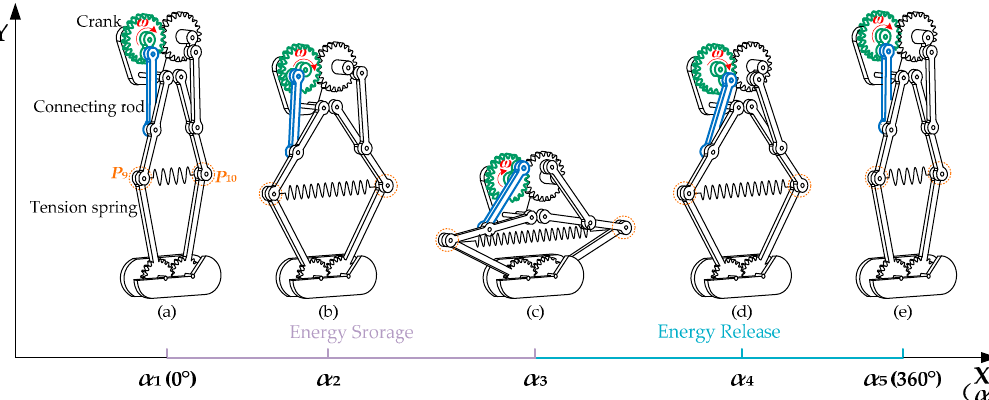
Figure 5. The energy storage and release phases. α in the horizontal axis represents the rotation angle of the crank. ( a ) The initial position of the energy storage phase, which means that the tension spring is in a natural state. ( b ) The general position of the energy storage phase. ( c ) The end position of the energy storage phase, which means that the energy storage of the tension spring is maximum. ( d ) The general position of the energy release phase. ( e ) The initial position of the energy storage phase.